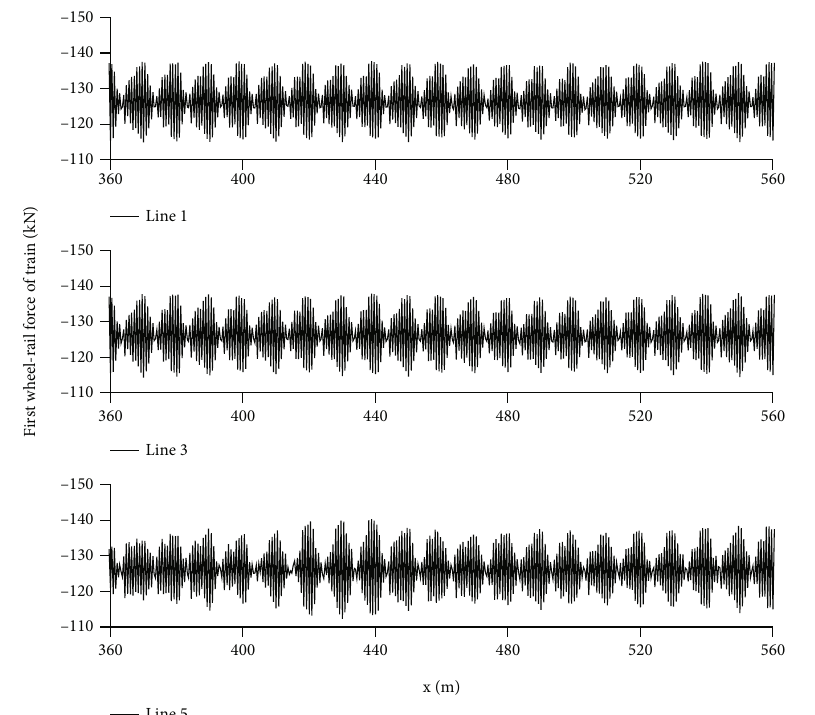
Figure 9: Force time history curve of fi rst wheel of